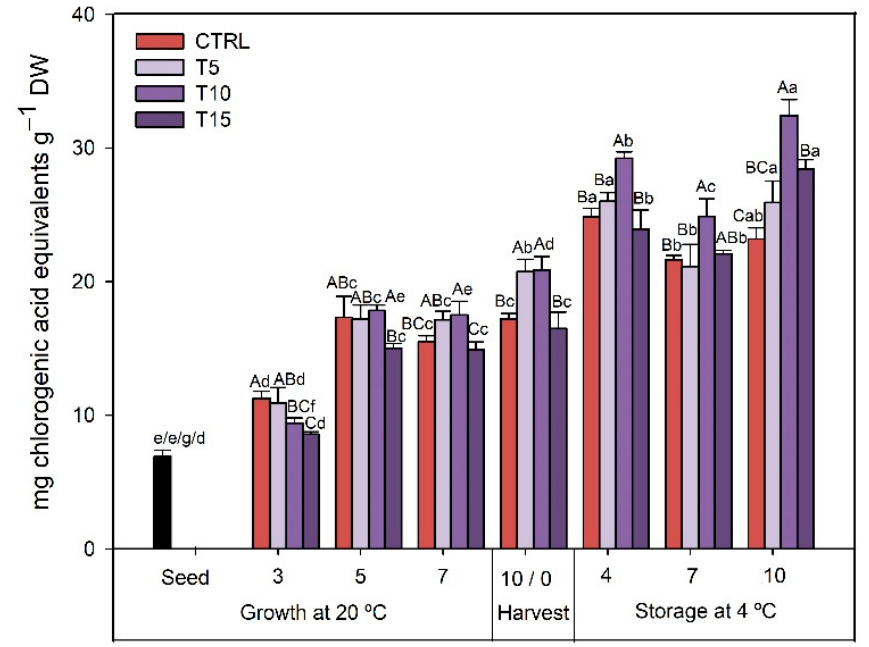
Figure 3. Total phenolic content of control (0, CTRL) or UV-B-treated (5, 10, and 15 kJ m − 2 ) red cabbage sprouts after 10 days growth at 20 ◦ C and stored 10 days at 4 ◦ C after harvest. Different capital letters indicate significant differences among treatments at p < 0.05 according to Tukey’s test ( n = 6, which were the plates collected, and each plate is a repetition). Different lowercase letters indicate significant differences among time of analysis of the same treatment at p < 0.05 according to Tukey’s test.